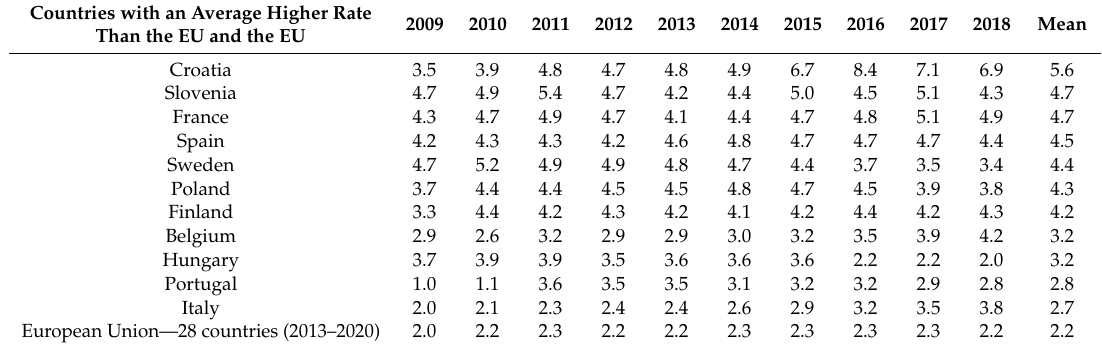
Table A2. Precarious workers rate (Eurostat 2019b).